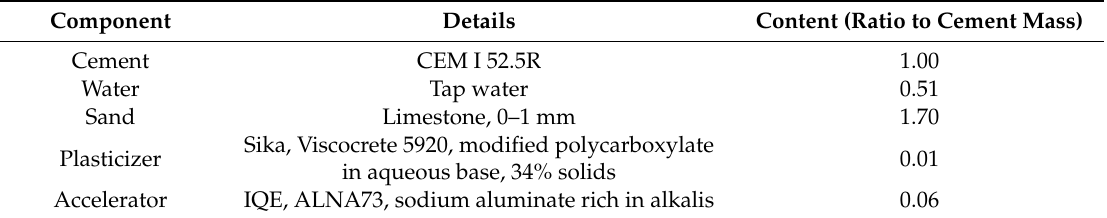
Table 2. Sprayed mortar